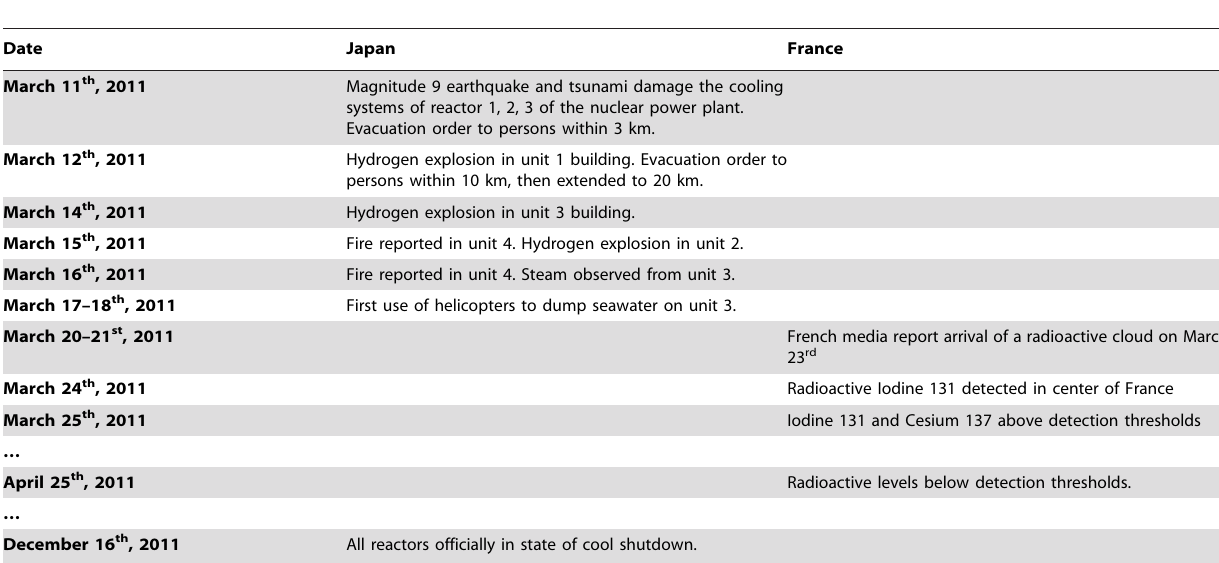
Table 2. Timeline of events of the Fukushima crisis in Japan and in France from references